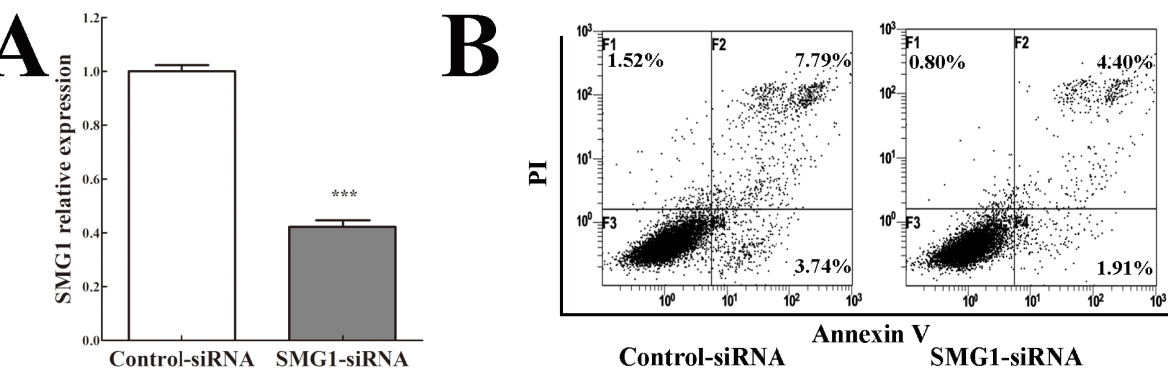
Figure 3. Effect of SMG1 knockdown on apoptosis in AML HEL cells. ( A ) SMG1 mRNA-targeting siRNA and a control-siRNA were transfected in SMG1-expressing HEL cells. The efficiency of SMG1 knockdown was examined by quantitative RT-PCR. *** p < 0.001 compared with the control-siRNA group; ( B ) SMG1 knockdown affect HEL cells apoptosis confirmed by flow